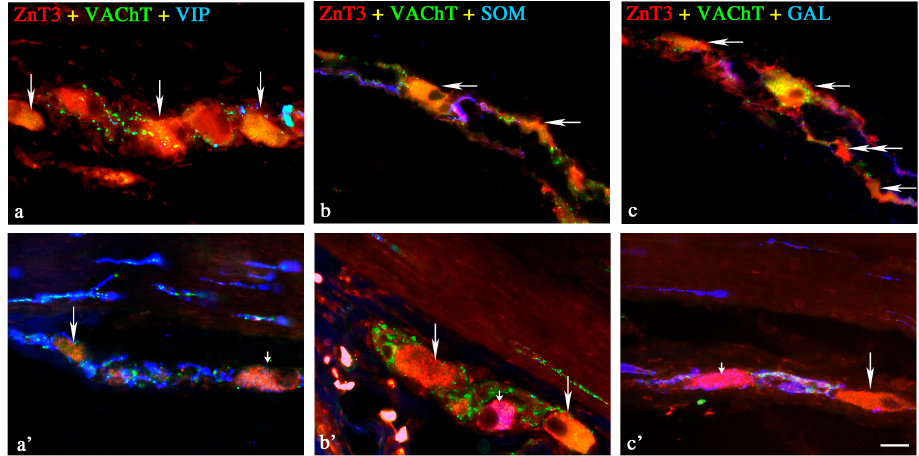
Figure 2. Representative images of ZnT3 + neurons located in the outer submucous plexus (OSP) of the porcine ileum. All images are composites of merged images taken separately from blue, red and green fluorescent channels. Control (C) group: ( a ) ZnT3 + /VAChT + /VIP − neurons are indicated with arrows; ( b ) ZnT3 + /VAChT + /SOM − neurons are indicated with arrows; ( c ) ZnT3 + /VAChT + /GAL − neurons are indicated with arrows; ZnT3 + /VAChT − /GAL − neuron is indicated with a double-headed arrow. Inflammatory (I) group: ( a’ ) ZnT3 + /VAChT + /VIP − neuron is indicated with an arrow; ZnT3 + /VAChT − /VIP + neuron is indicated with a small arrow; ( b’ ) ZnT3 + /VAChT − /SOM + neuron is indicated with a small arrow; ZnT3 + /VAChT + /VIP − neurons are indicated with arrows; ( c’ ) ZnT3 + /VAChT − /GAL + neuron is indicated with a small arrow; ZnT3 + /VAChT + /GAL − neuron is indicated with an arrow. Scale bar 25 µm.